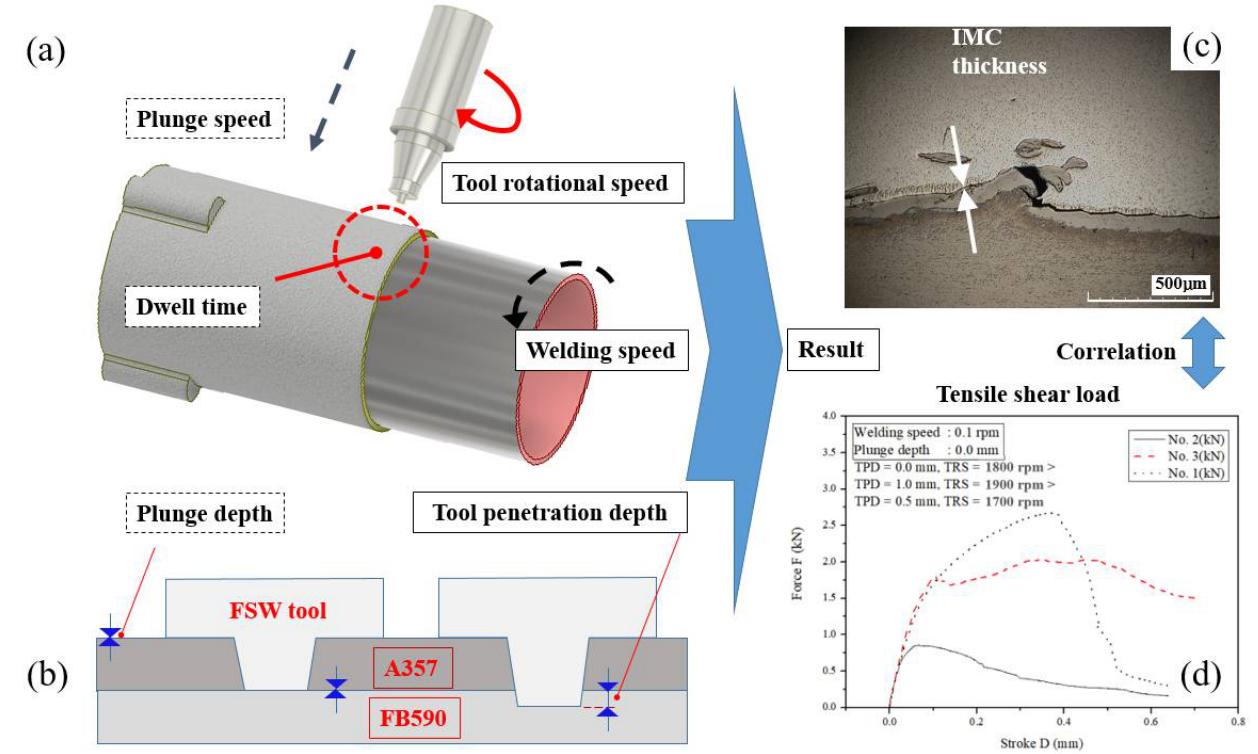
Figure 2. Schematic illustration of FSLW experimental process on IMC thickness and tensile shear load (TSL) by process parameters; ( a ) process parameter; ( b ) plunge depth and TPD; ( c ) IMC thickness; and ( d ) TSL.